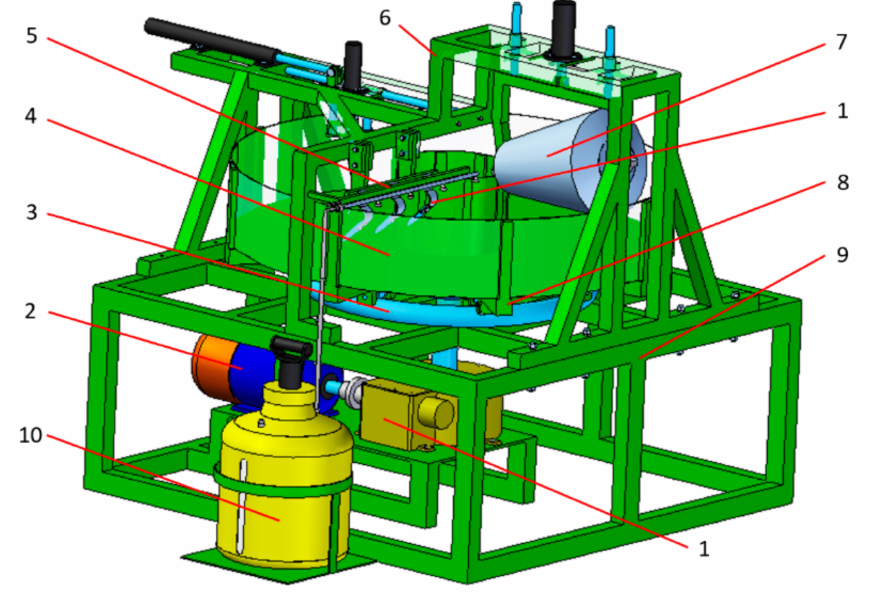
Figure 3. The wear test device consists of: transmission (1), motor (2), running rail (3), bowl (4), sample holder (5), supporting frame (6), compacting roller (7), bowl frame (8), main frame (9), water tank (10)